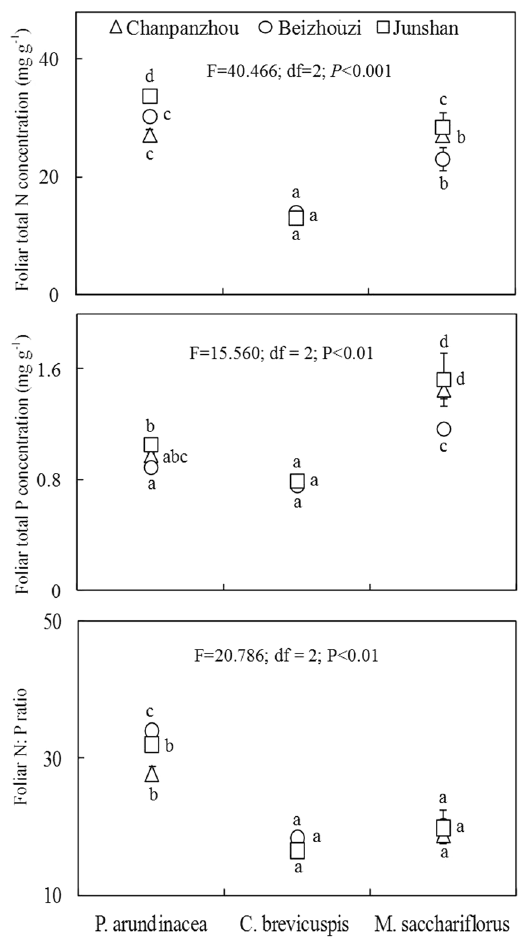
Figure 2. Foliar total nitrogen (N) and total phosphorus (P) concentrations, and foliar N:P ratio of the 3 wetland species distributed along an elevation gradient in 3 lakeshore areas of Dongting Lake,